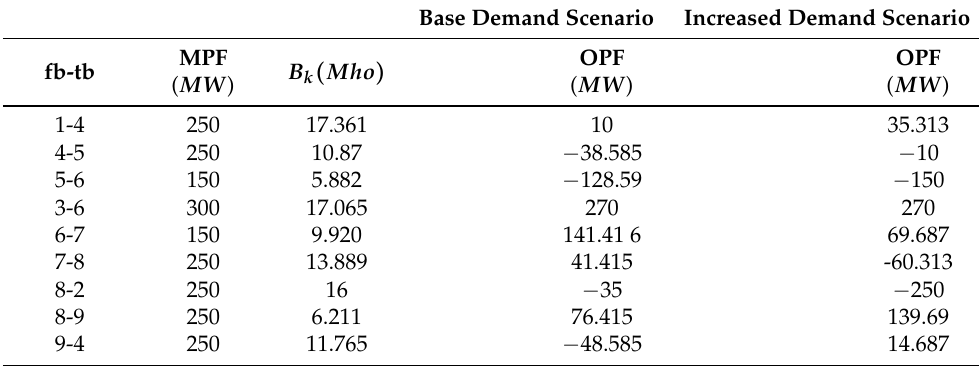
Table 7. The results of the optimal power flow of the 9-bus system with increase in